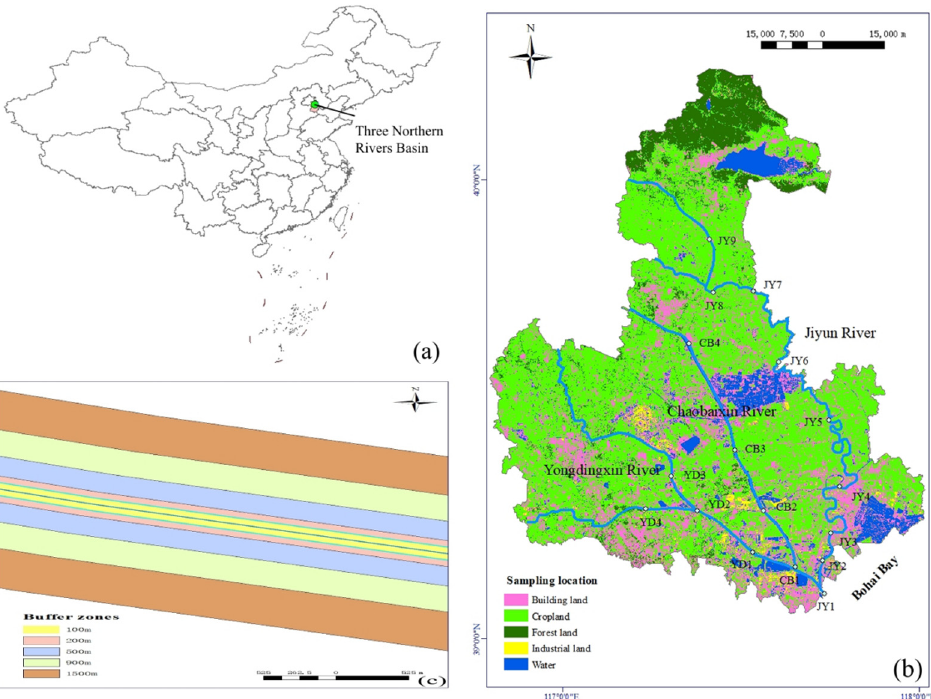
Figure 1. ( a ) The TNRs catchment in China; ( b ) sampling sites and land use types in the TNRs catch- ment based on Landsat satellite data in 2021; ( c ) buffer zones of different river areas.